Question: Write the caption for this figure.
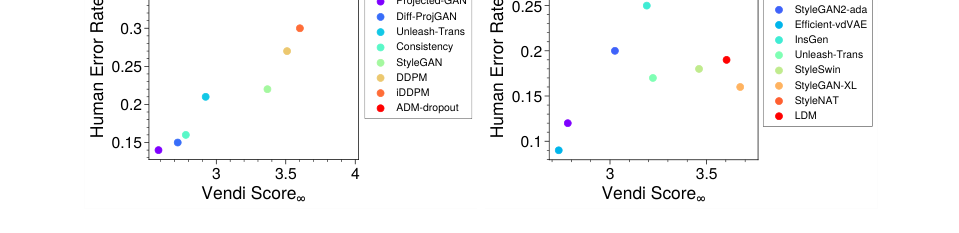
Answer: Vendi Score∞is well-correlated with human evaluation on LSUN-Bedroom (Left) and FFHQ (Right) datasets.